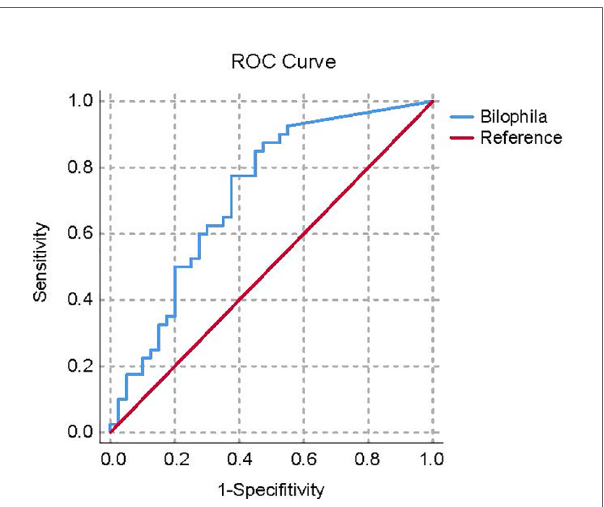
FIGURE 5 | ROC curve plots of the bacteria able to discriminate Con subjects from HUA subjects. HUA, hyperuricemia; Con, control.